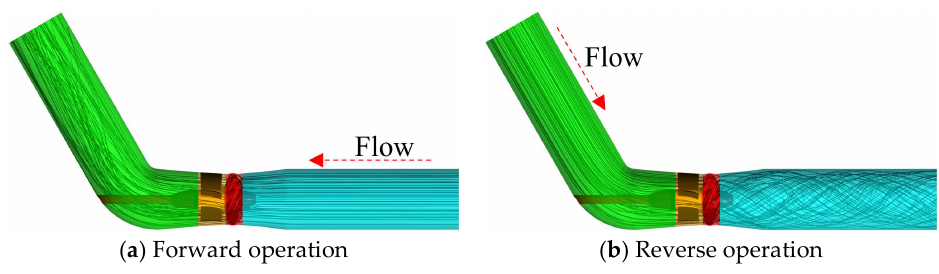
Figure 12. 1.1 Q d 3D streamline diagram.